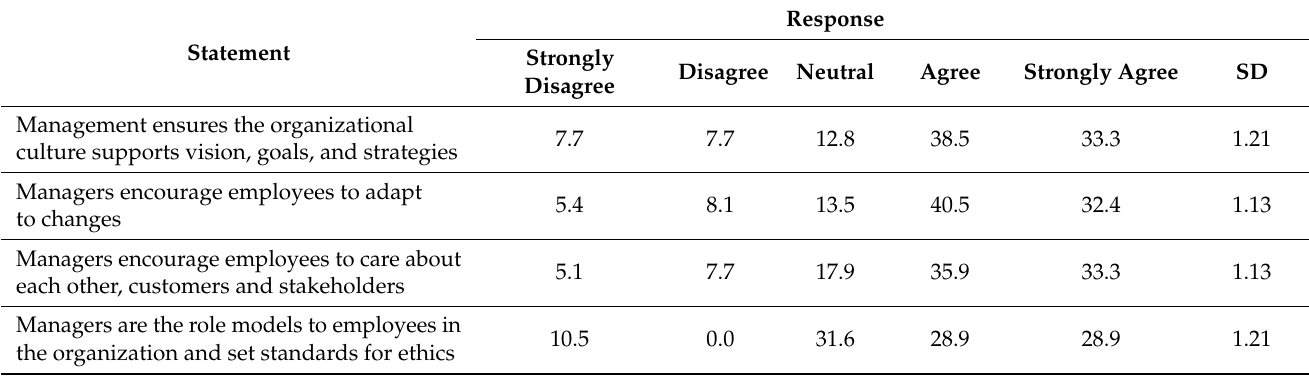
Table 2. Descriptive statistics for organizational culture change and performance at the changing stage.